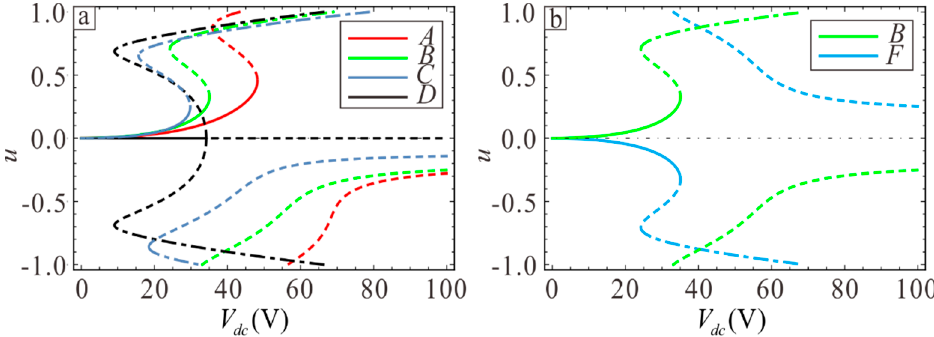
Figure 11. The relationship between the DC voltage and the static equilibrium point. ( a ) Static equilibrium point for A, B, C, and D. ( b ) Static equilibrium point for B and F cases. Solid lines represent stable solutions and dashed lines represent unstable solutions. The dotted line shows the stable solution without physical meaning.